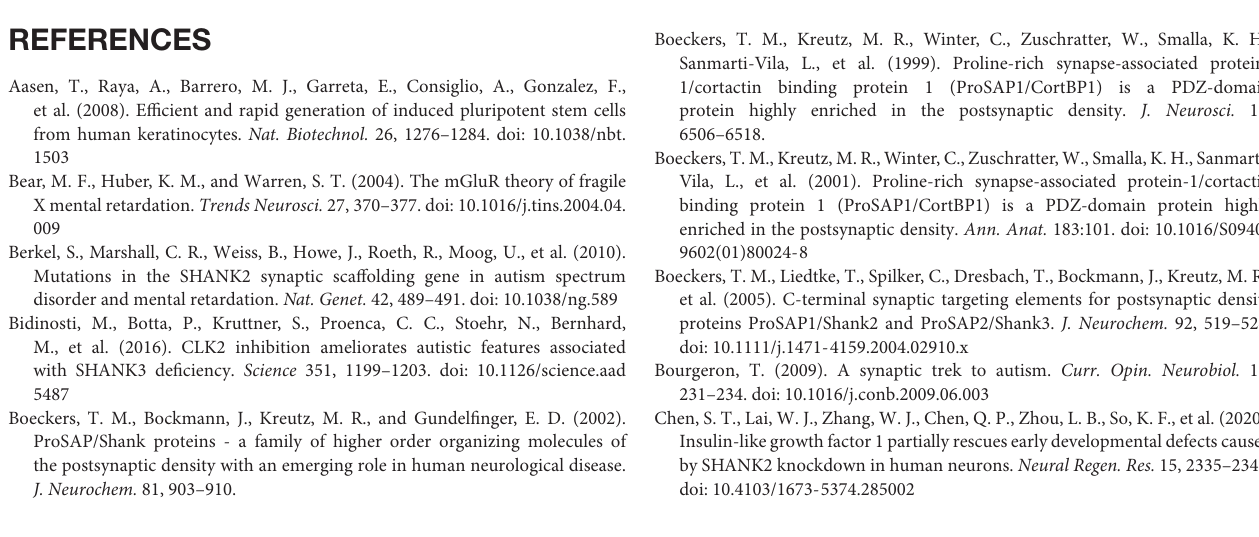
differentiation into mesoderm, endoderm ectoderm. Cells stained for α -ACTININ, alpha-fetoprotein (AFP), and β -III-TUBULIN. Scale bar = 50 µ m. (E) Karyograms. Supplementary Figure 2 | Alterations in hiPSC and derived neurons. (A) hiPSCs stained for SHANK2. Scale bar = 50 µ m. (B,C) Number of primary neurites in neurons d21 (B) and d42 (C) . Scale bar = 10 µ m. (D) Caspase3 activity in colorimetric activity assay measured at 405 nm in neurons d21 and d42, n = 4. (E) hiPSCs stained for SHANK3. Scale bar = 50 µ m. (F–H) SHANK3 RNA and SHANK3 protein expression in hiPSCs (F) , neurons d21 (G) , and d42 (H) . Data were normalized to mean of parents if indicated. Mean ± SEM. Significance level was set to * p ≤ 0.05. Supplementary Figure 3 | Expression of inhibitory and excitatory markers in hiPSC-derived neurons. (A) Analysis of total synaptic puncta intensity for SHANK2, SHANK3, HOMER1, mGluR5, GluA2, and GluN1. (B) Analysis of puncta per 30 µ m of dendrite for SHANK2, SHANK3, HOMER1, mGluR5, GluA2, and GluN1. Mean ± SEM. (C) Analysis of total synaptic puncta intensity for vGluT1, vGAT, and BSN. (D) Analysis of puncta per 30 µ m of dendrite for vGluT1, vGAT, and BSN. Mean ± SEM. (E) Whole neuron d42 stained against SHANK2, vGLUT1, and NFH. (F) Analysis of total synaptic puncta intensity for vGLuT1, co-localizing with SHANK2. (G) Analysis of puncta per 30 µ m of dendrite for vGLuT1, co-localizing with SHANK2. (H) Total protein lysate of neurons d42 immunoblotted against GAD65, mGluR5, and GLUA2 relative to NFH. Data were normalized to mean of parents. Mean ± SEM. vGluT1, vesicular glutamate transporter 1; vGAT, vesicular GABA transporter; NFH, neurofilament heavy chain; BSN, bassoon; mGluR5, metabotropic glutamate receptor 5; GluA2, AMPA receptor subunit 2; GluN1, NMDA receptor subunit 1, GAD65, glutamic acid decarboxylase 65. Box plots show the median and the distribution of the minimum to the maximum data. One-way ANOVA followed by Tukey’s post hoc analysis. Significance levels were set to * p ≤ 0.05, ** p ≤ 0.01, *** p ≤ 0.001, and **** p ≤ 0.0001. Supplementary Figure 4 | ERK and AKT signaling in neurons and Shank2 ( − / − ) mice. (A) Total protein lysate of neurons d21 immunoblotted against ERK1/2 and phospho-ERK1/2 relative to NFH. (B) Total protein lysate of neurons d21 immunoblotted against AKT and phospho-AKT relative to NFH. (C) Total protein lysate of neurons d42 immunoblotted against ERK1/2 and phospho-ERK1/2 relative to NFH. (D) Total protein lysate of neurons d42 immunoblotted against AKT and phospho-AKT relative to NFH. (E) Total protein lysate of neurons d21 immunoblotted against CREB and phospho-CREB relative to NFH. (F) Total protein lysate of neurons d42 immunoblotted against CREB and phospho-CREB relative to NFH. (G) AKT and phospho-AKT protein expression relative to β -ACTIN ( n = 4) in striatum of P7 Shank2 ( + / + ) , Shank2 ( + / − ), and Shank2 ( − / − ) mice. Mean ± SEM, one-way ANOVA, followed by Tukey’s post hoc analysis. Significance levels were set to * p ≤ 0.05, ** p ≤ 0.01, *** p ≤ 0.001, and **** p ≤